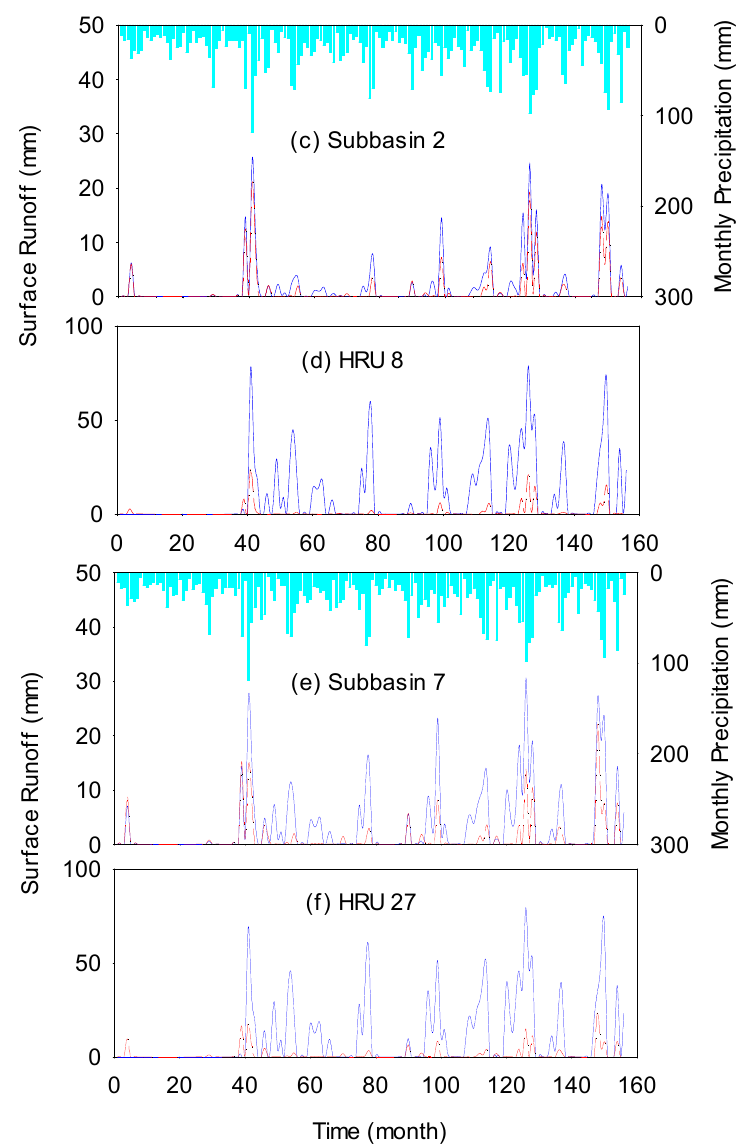
Figure 7. Comparison of surface runoff simulated by the coupled PD-SWAT and SWAT for three selected sub-basins and their typical HRUs with depressions under extreme low precipitation: ( a ) sub-basin 10 (depression-dominated sub-basin); ( b ) HRU 40 in sub-basin 10; ( c ) sub-basin 2 (lowest depression coverage); ( d ) HRU 8 in sub-basin 2; ( e ) sub-basin 7; and ( f ) HRU 27 in sub-basin 7.